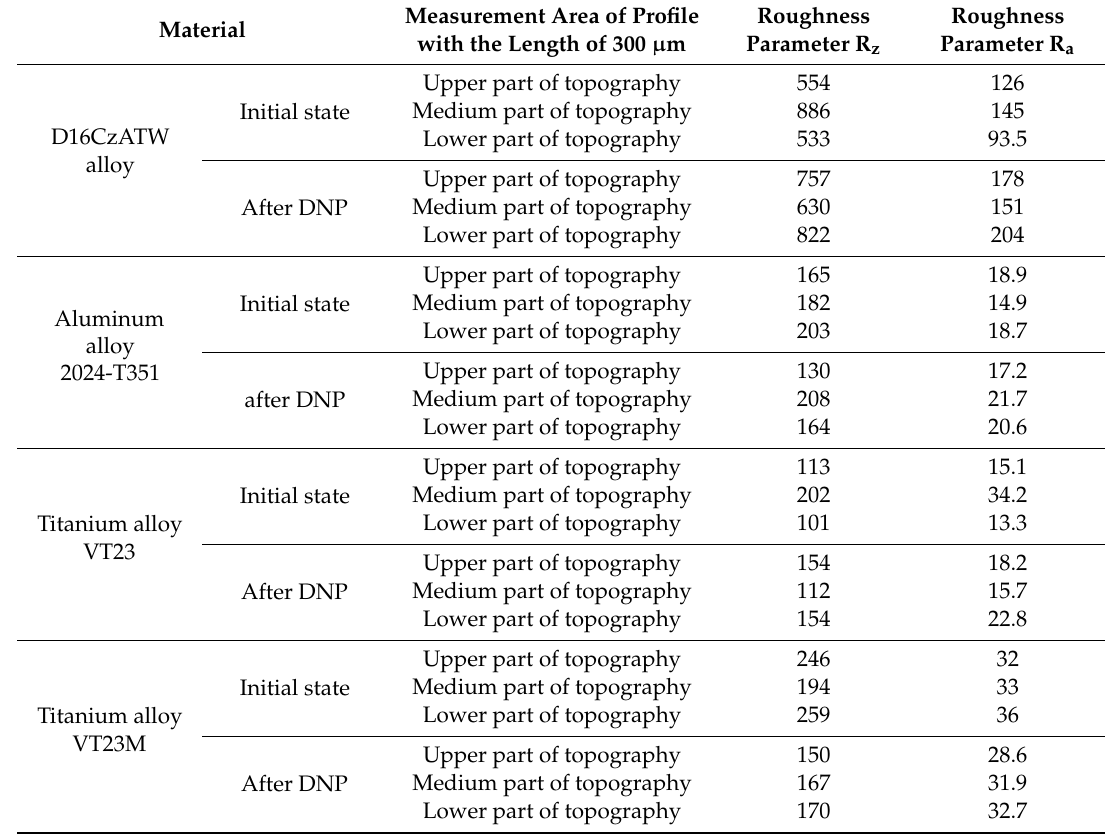
Table 3. Roughness parameters R z and R a of specimen surfaces in the initial state and after impulse introduction of